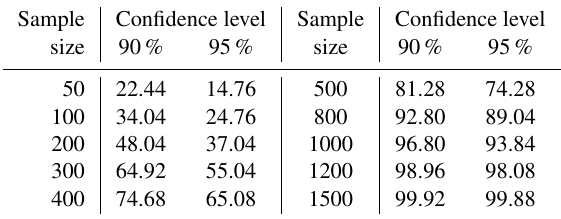
Table 4. The power of the homogeneity test (%). Null hypothesis: GARCH(1,1) process with different block sizes, with sample size n = 100. Alternative hypothesis: VAR(1) process simulated with coefficient matrices A and C . Block